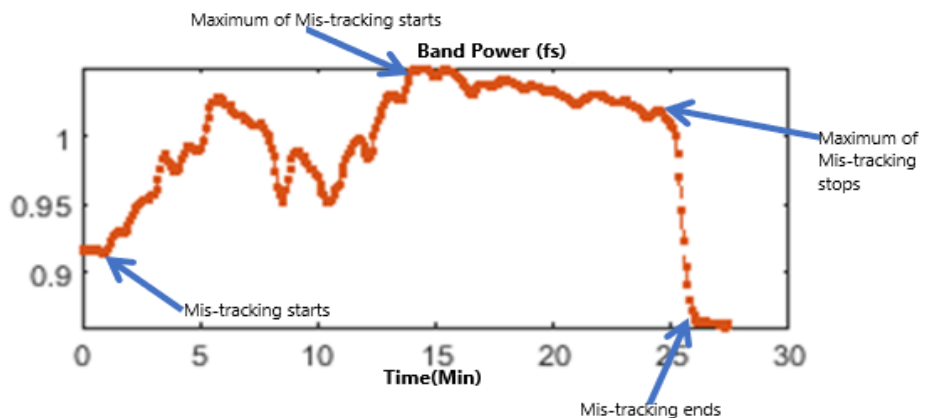
Figure 5. Power feature values over time for the signals collected during tracking experiments and no-load condition.